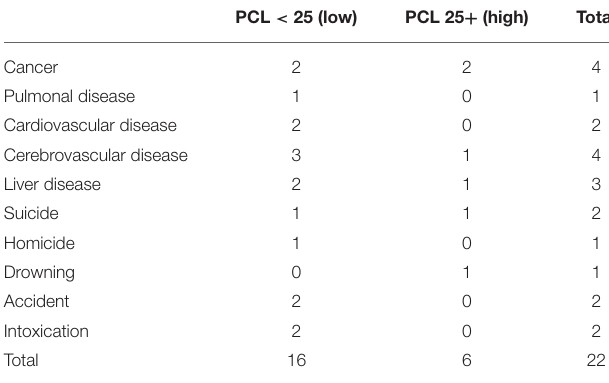
TABLE 1 | Causes of death in low and high psychopathy